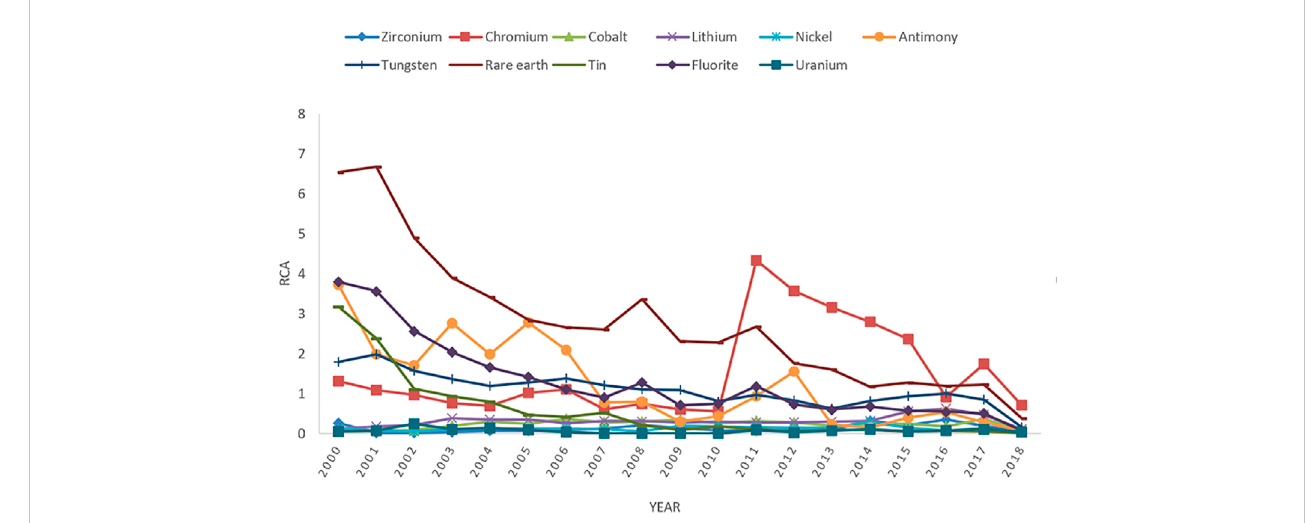
FIGURE 5 Revealed comparative advantage of China ’ s strategic and critical mineral articles.